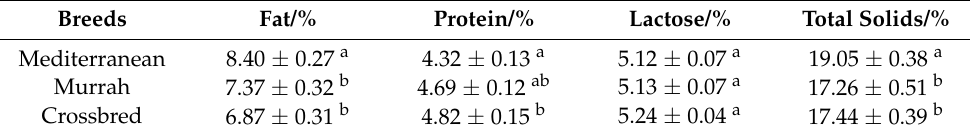
Table 1. Comparation of the main milk composition of Mediterranean, Murrah, and crossbred buffalo.